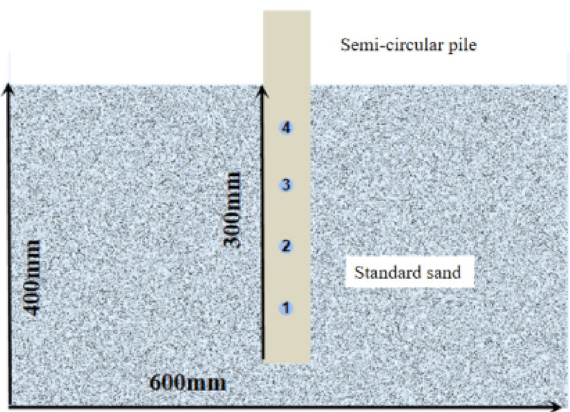
Figure 11. Setup of numerical model.